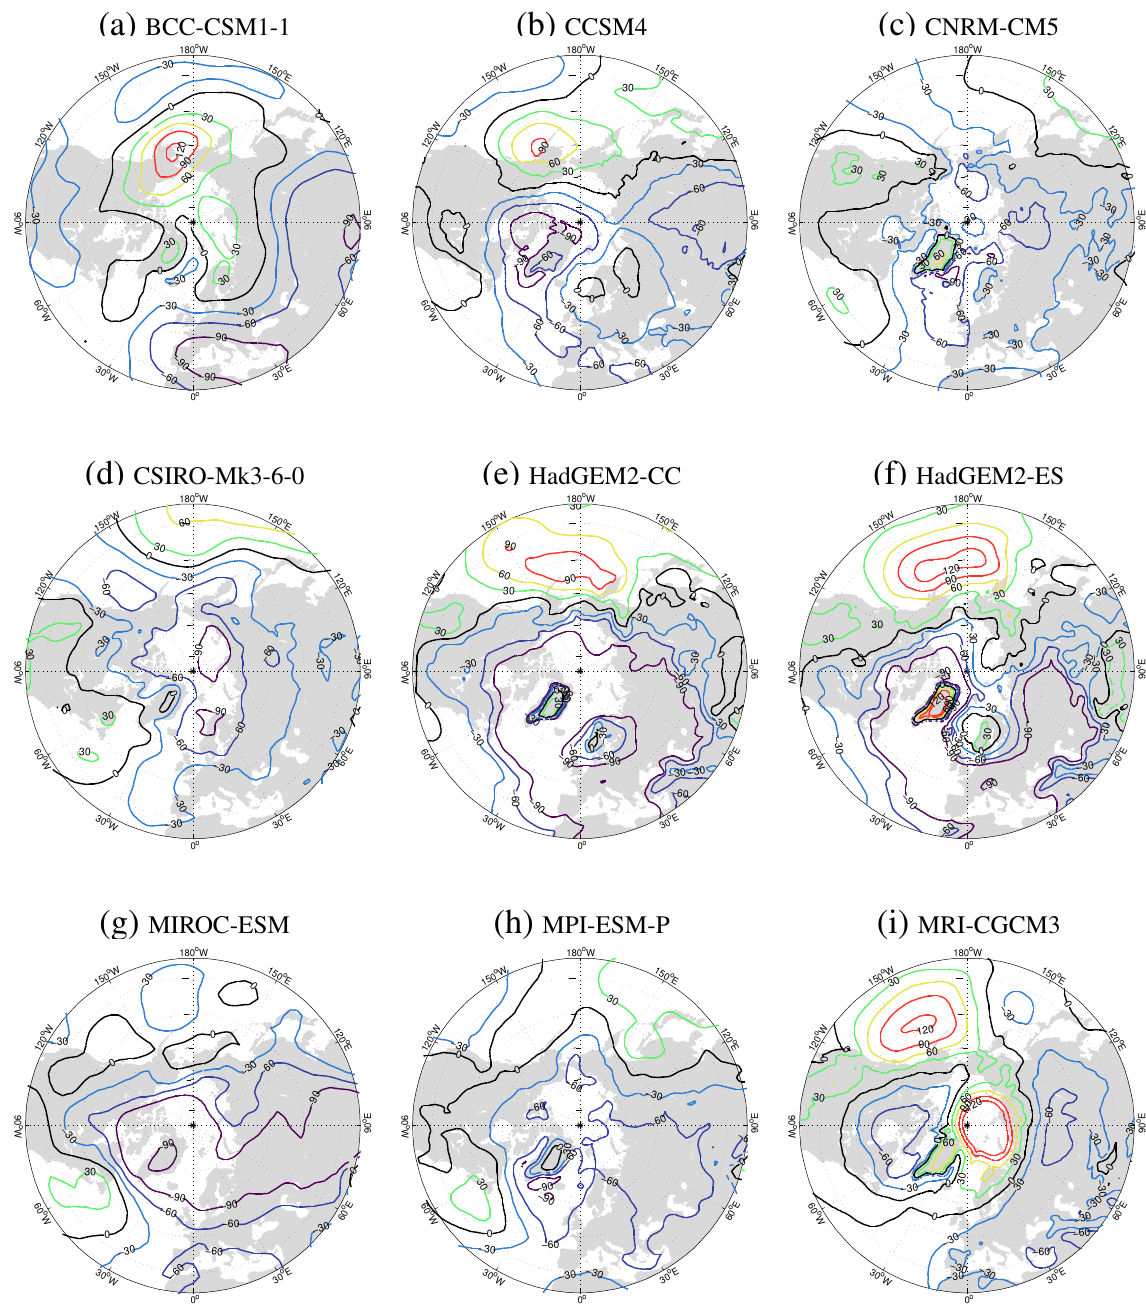
Figure 7. Annual mean surface pressure anomalies (in Pa) simulated by the GCMs for the MH (reference period AD1850–1900).